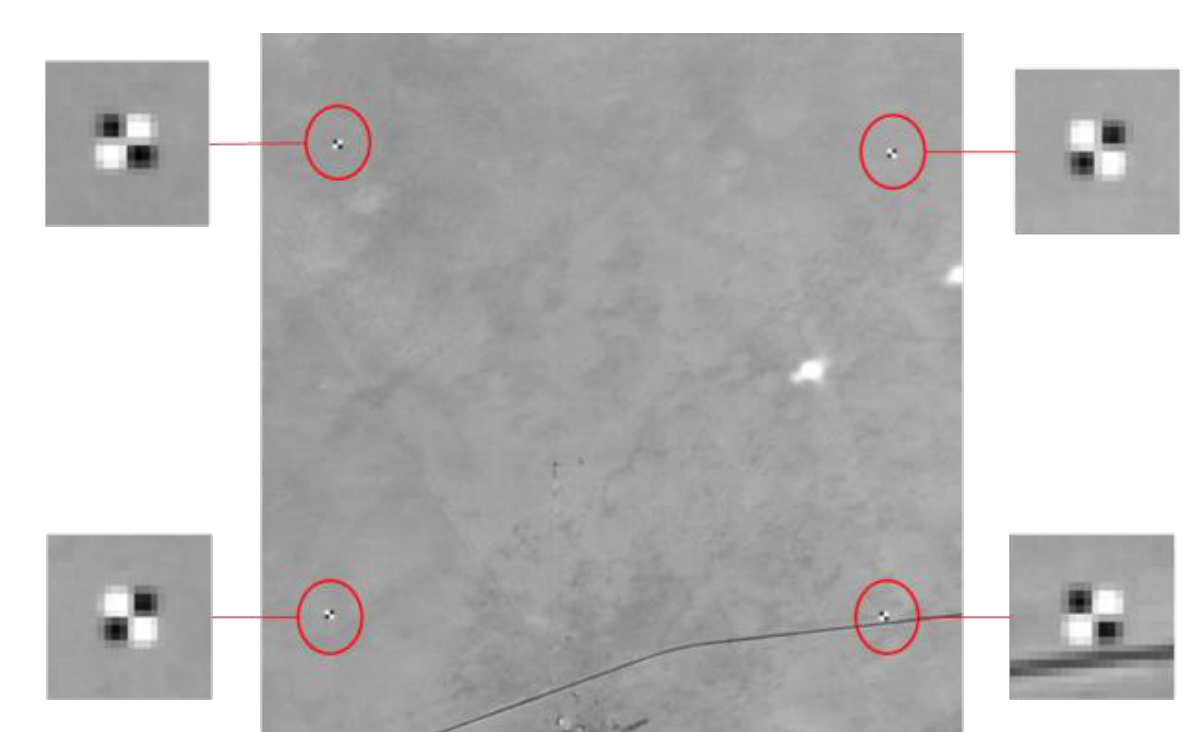
Internal distortion of LFC2. distortion of LFC2.